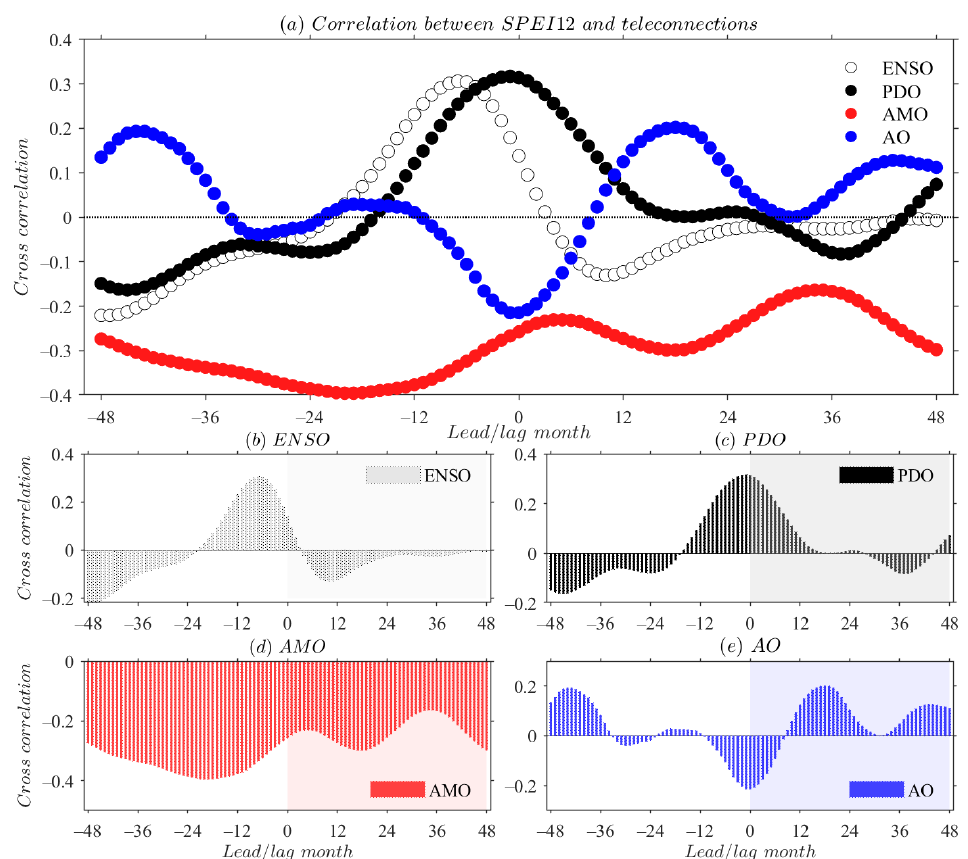
Figure 8. Cross-correlation coefficients between Xinjiang SPEI12 and ( a ) teleconnection indices, ( b ) ENSO, ( c ) PDO, ( d ) AMO, and ( e ) AO with considering lead and lag for 48 month. Horizontal axis represents lead/lag month, and vertical axis represents correlation coefficient. On the horizontal axis, − k (+k) indicates that SPEI leads (lags) the climate index by k months. Shaded areas indicate SPEI12 lagged teleconnection factor